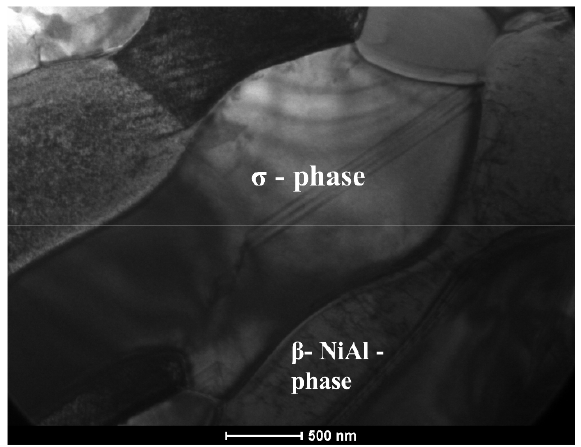
Figure 3. TEM images of the cross-section of the Hf and Pt-modified aluminide coating, σ and β-NiAl phase.